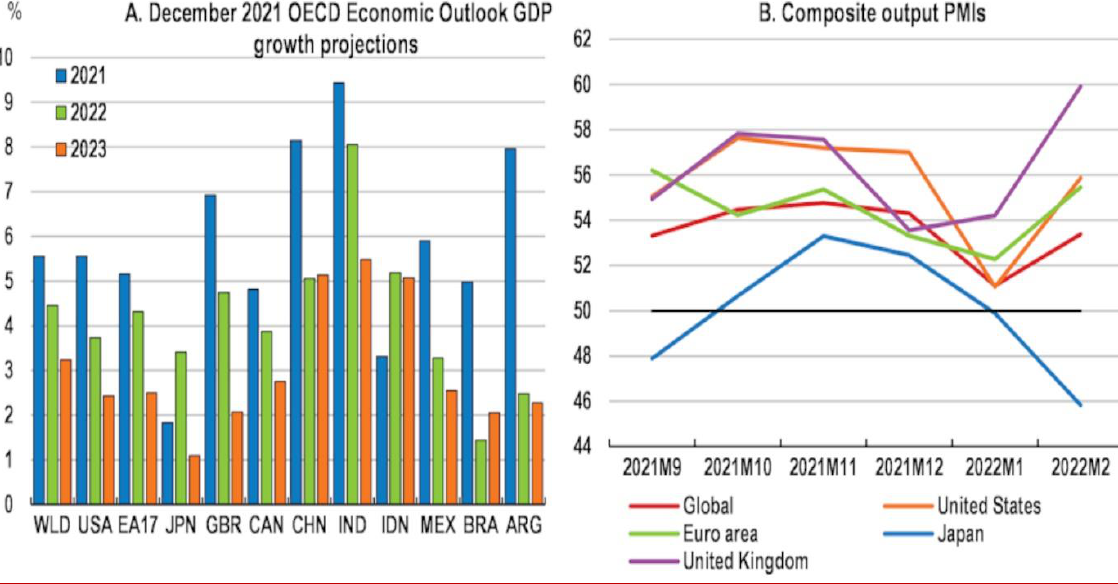
Figure 1. Correlations between variables with FCM.